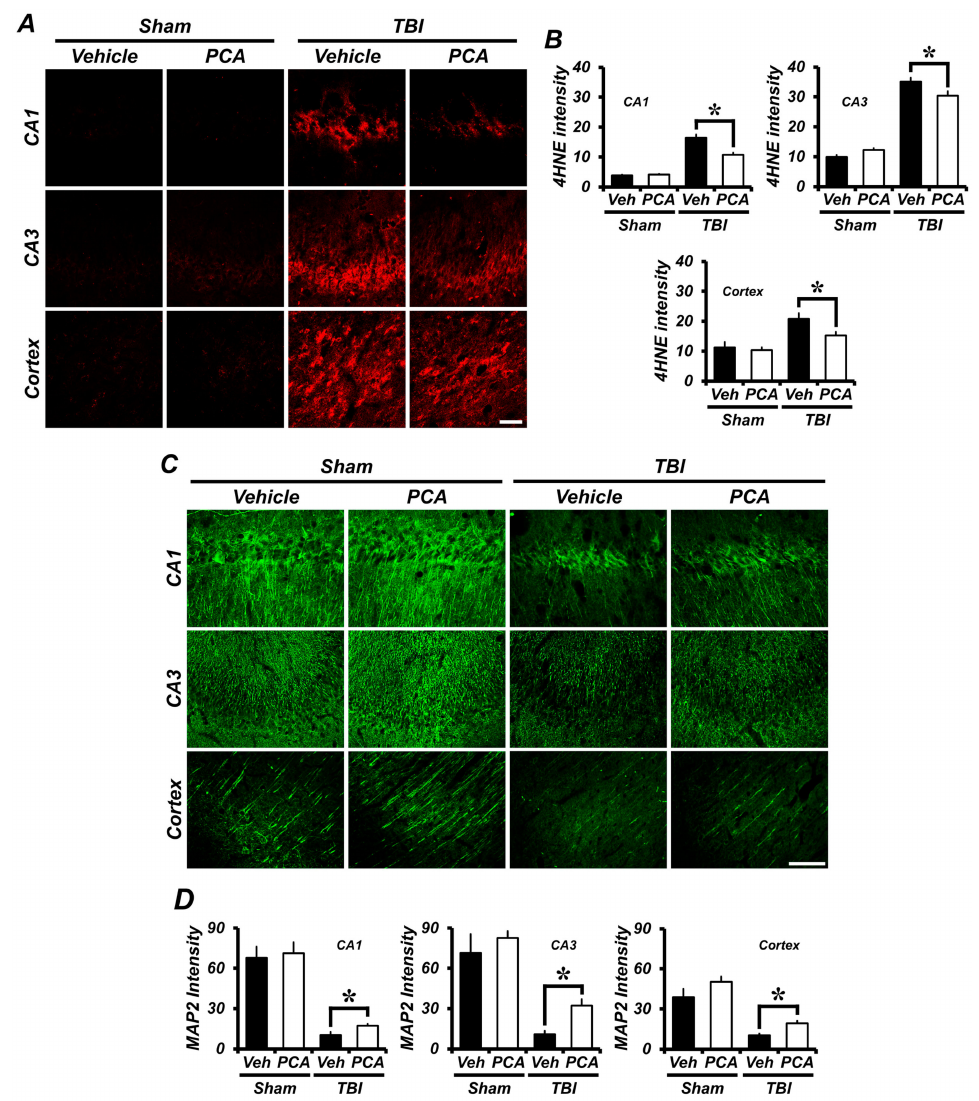
Figure 2. PCA reduces TBI-induced oxidative injury. ( A ) Neuronal oxidative injury was examined by 4-hydroxy-2-nonenal (4HNE) ( red color ) staining. Fluorescence images represent the degree of oxidative injury present in the hippocampus and cortex at 24 h after TBI. PCA administration reduces the intensity of oxidative injury in the hippocampus and cortex when compared to the vehicle-treated group. Scale bar indicates 50 µ m. ( B ) The bar graph shows the 4HNE fluorescence intensity in the hippocampus and cortex. ( C ) Dendritic loss was examined by microtubule-associated protein 2 (MAP2) ( green color ) staining. Fluorescence images represent the results of MAP2 in the hippocampus and cortex at 24 h after TBI. PCA administration reduced the intensity of dendritic loss in the hippocampus and cortex when compared to the vehicle-treated group. Scale bar indicates 100 µ m. ( D ) The bar graph shows the MAP2 fluorescence intensity in the hippocampus and cortex. Data are mean ± SEM, n = 5 from each sham group and n = 10 from each TBI group. * Significantly different from vehicle-treated group, p <